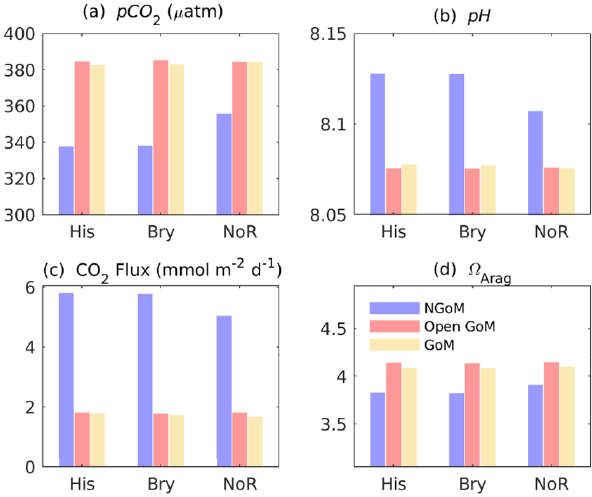
Figure 12. Multiyear synoptic of sea surface p CO 2 , pH, CO 2 air– sea flux, and (cid:127) Arag with His, Bry, and NoR experiments. Color bars show the corresponding mean level from 2001 to 2019. Color leg- end: blue – NGoM, red – open GoM, yellow – GoM-wide. The units for p CO 2 , pH, CO 2 flux, and (cid:127) Arag are µatm, unitless (full scale), mmolm − 2 d − 1 , and unitless, respectively (note that the CO 2 air– sea flux used the ocean convention, with a positive value indicating transport from air to sea; i.e., the ocean is a